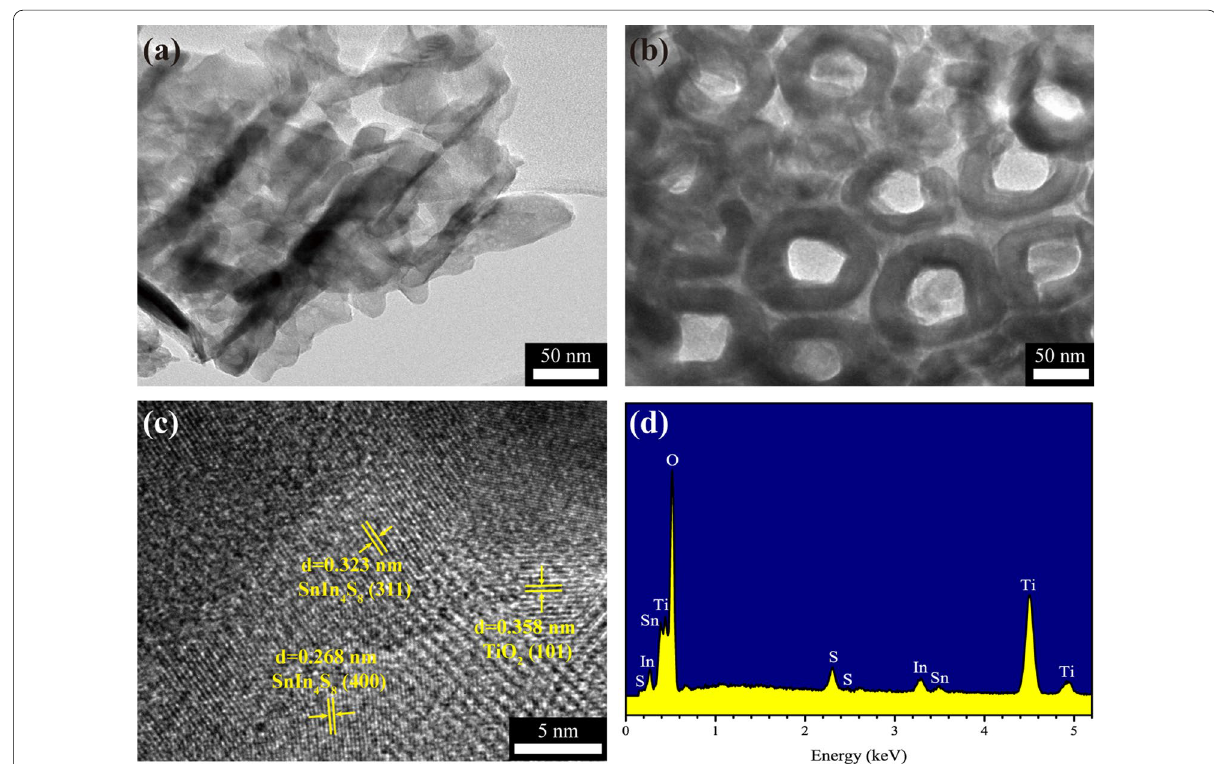
Fig. 4 a , b TEM, and c HRTEM images, and d EDS spectrum of the SnIn 4 S 8 /TiO 2 composite